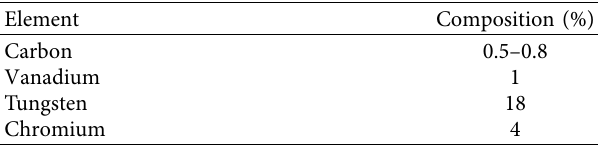
Table 2: Chemical composition of HSS cutting tool.